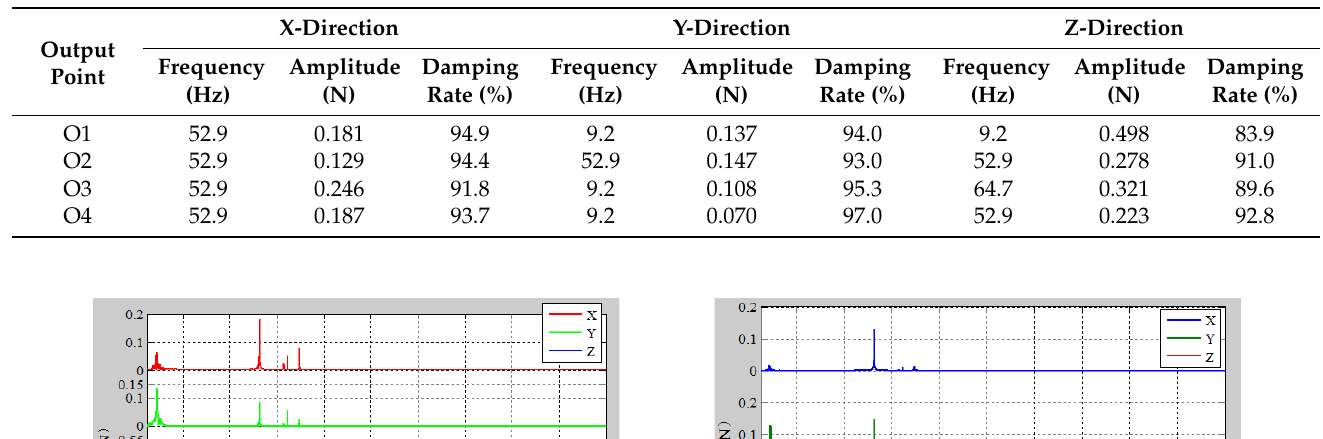
Table 1. Maximum reaction force of each output point and damping efficiency.